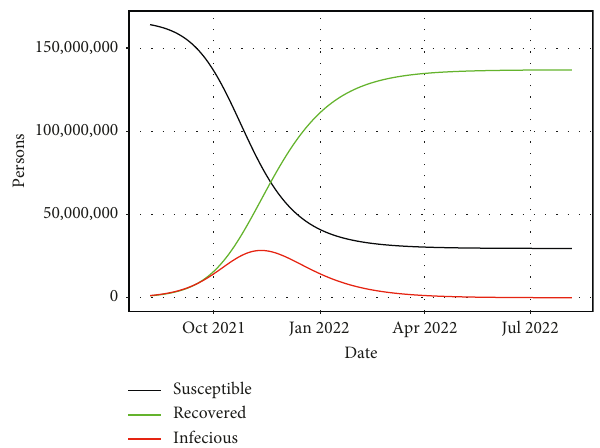
Figure 3: Prediction of the COVID-19 outbreak in Bangladesh based on the SIR model (red color � infectious/confirmed cases, black color � susceptible, and green color � recovered